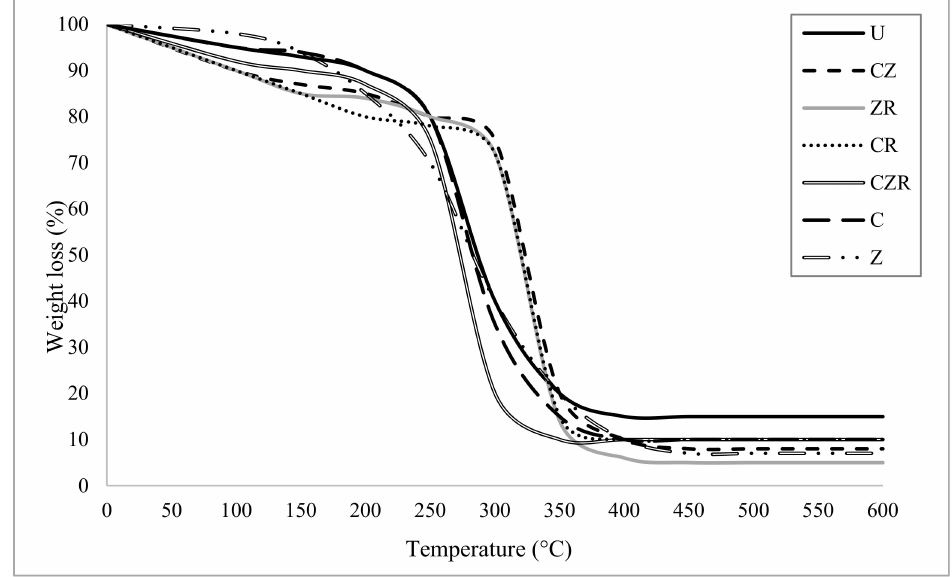
Figure 5. Thermogravimetric analysis (TGA) curves of the uncoated (U), chitosan and zein coated (CZ), blend zein and rosemary oil coated (ZR), blend chitosan and rosemary oil coated (CR), chitosan and blend zein, rosemary oil coated (CZR), pure chitosan in one layer coated (C) and the pure zein in one layer coated (Z)